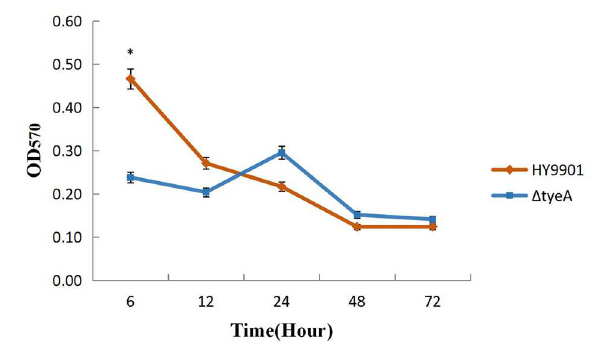
FIGURE 6 | Measurement of biofilm by crystal violet ammonium oxalate. *indicates significant difference compared with the control group ( p < 0.05). **indicates extremely significant difference compared with the control group ( p <